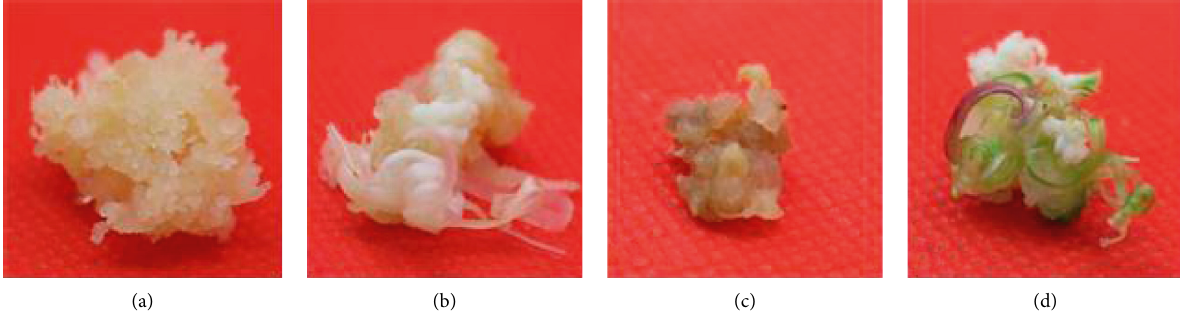
Figure 1: Morphological stages of callus genesis in maize from immature embryos. (a) Embryonic callus (EC) that were yellow, loose, and small granular. (b) Callus, which only expanded (IDC), accompanied by a large number of nonremovable root bud structures. (c) Browning dead callus (BDC), which cannot be further cultured. (d) Incipient redifferentiation callus (IRC) produced on the regeneration medium.